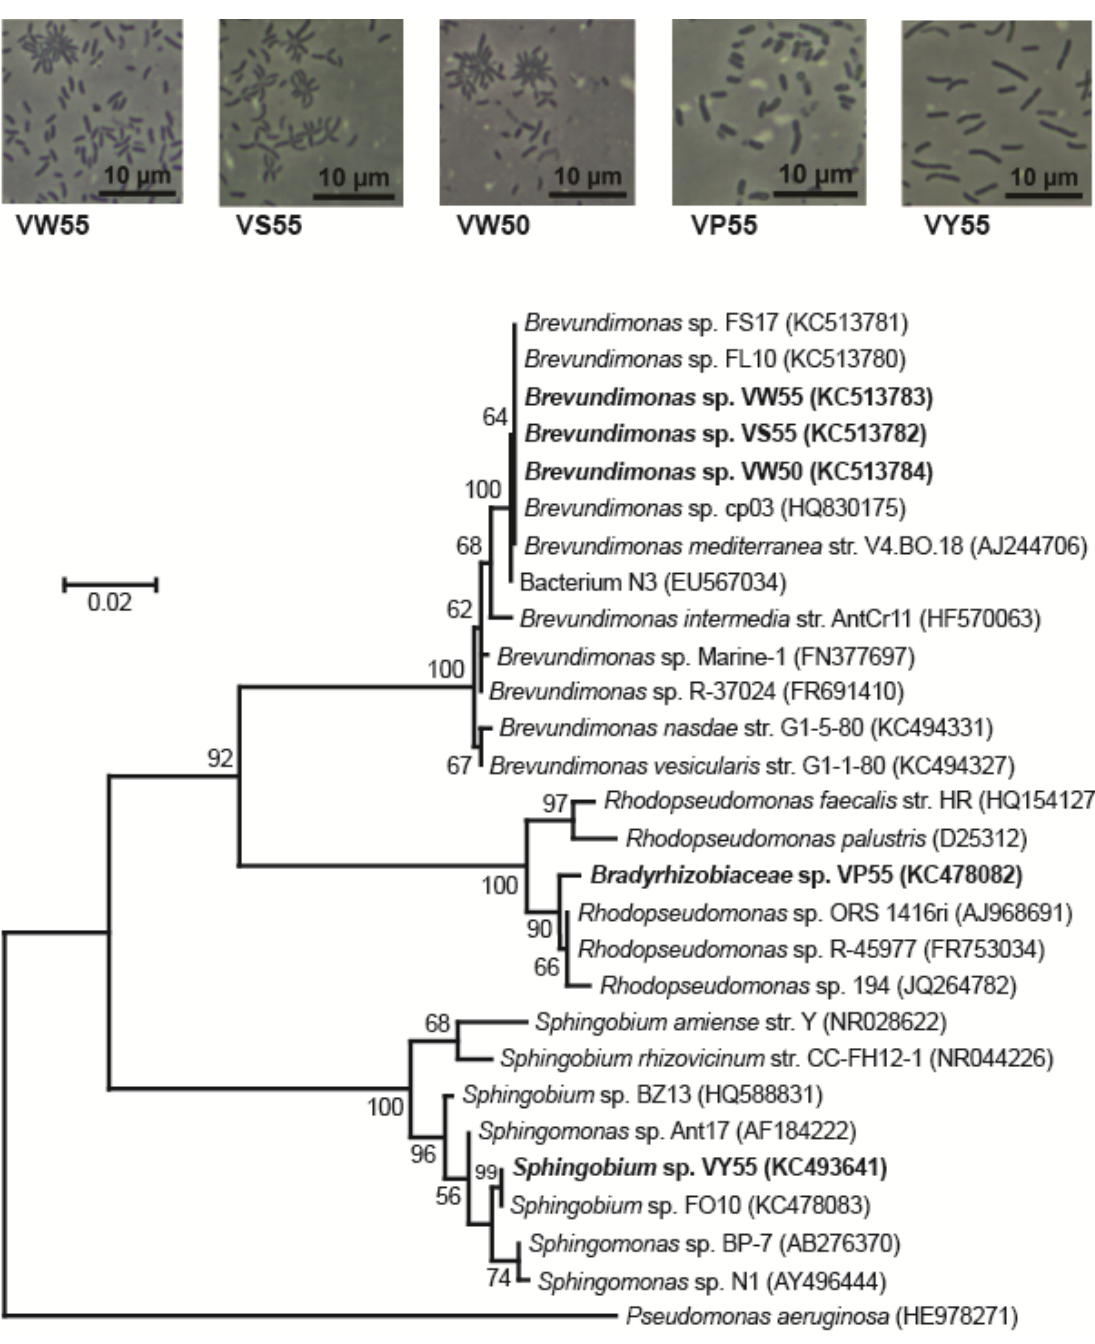
Figure 3. Morphology and phylogeny of gram-negative Lake Vanda isolates. ( A ) Phase-contrast photomicrographs showing cell morphology and arrangement of each strain; ( B ) Phylogenetic tree generated from 1369 nucleotide positions of the 16S rRNA gene. Pseudomonas aeruginosa is the outgroup organism, and bootstrap values > 50% are shown at the branching points. GenBank accession numbers are listed in